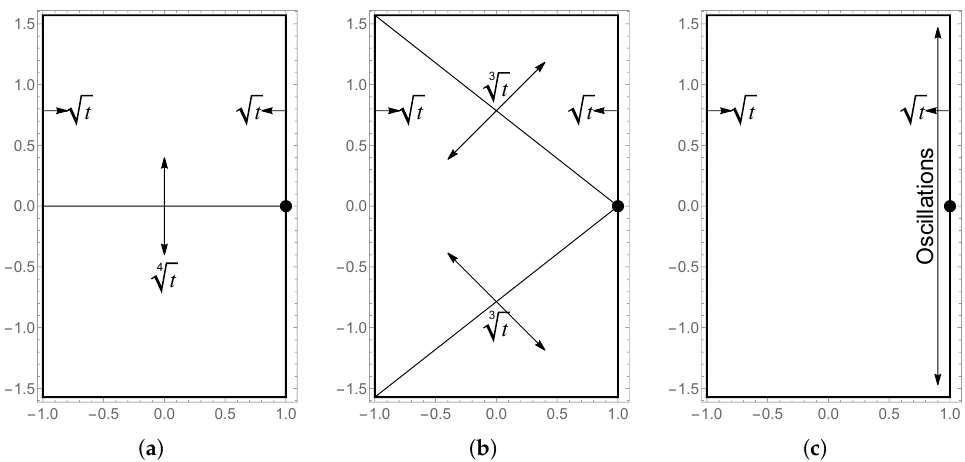
Figure 3. Boundary layer charts on Ω = [ − 1,1 ] × [ − π /2, π /2 ] , where a symmetric concentrated load is acting on point ( 1,0 ) . ( a ) Parabolic. ( b ) Hyperbolic. ( c ) Elliptic (no characteristic